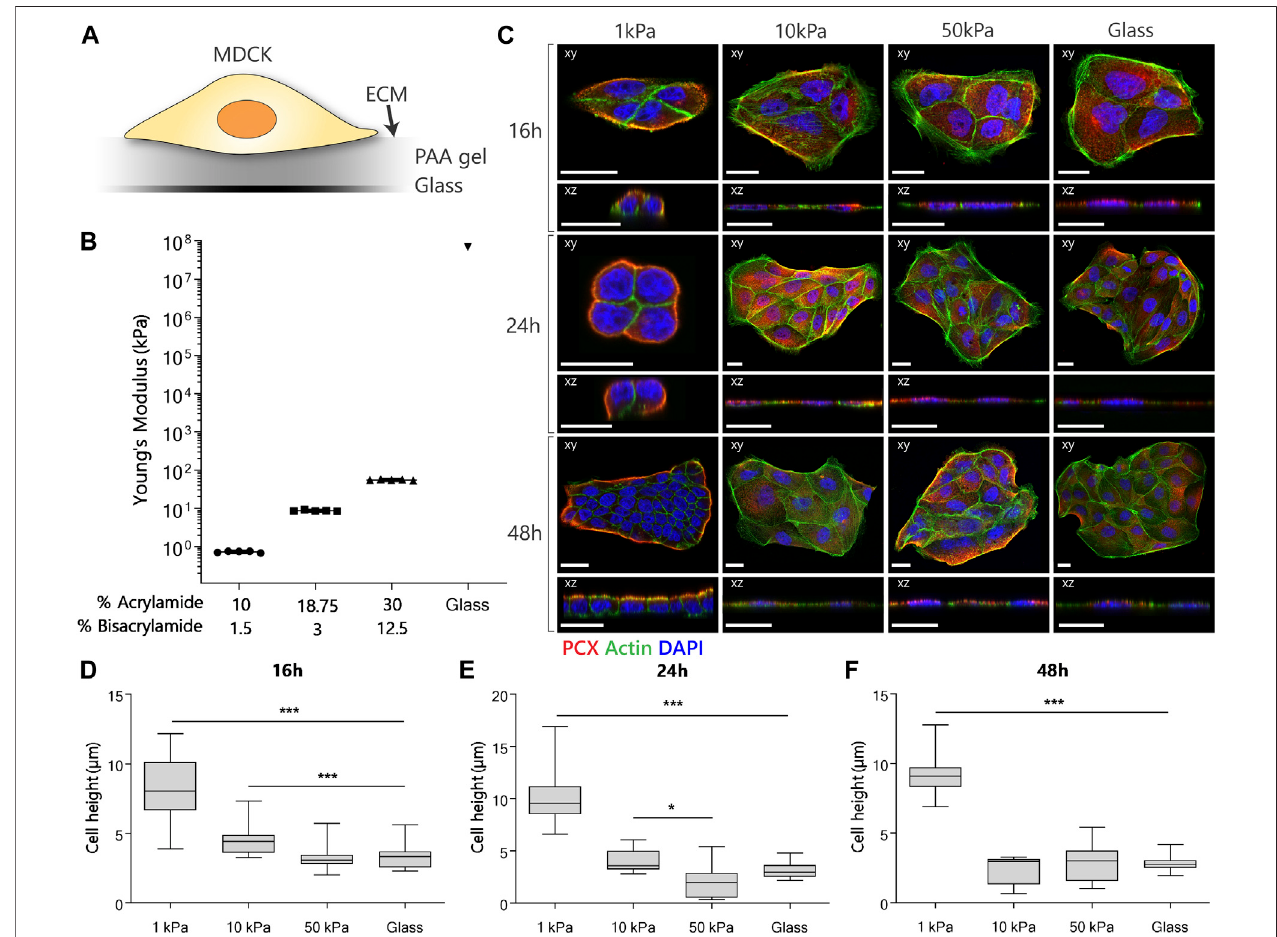
FIGURE 1 | MDCK polarization and morphology when cultured on substrates with different stiffnesses. (A) Experimental setup for the examination of the effect of different substrate stiffnesses on the establishment of apical-basal polarization. (B) The Young ’ s modulus of the substrates was veri fi ed using nanoindentation. (C) Representative fl uorescent images of MDCKs cultured on PAA substrates with an elastic modulus of 1, 10 and 50 kPa or on glass controls. The cells were stained for podocalyxin (red), actin (green) and nuclei (blue). Confocal sections are shown in both xy (top) and xz (bottom) direction. Scale bars are 20 µm. (D/E/F) Cell height quanti fi cation of MDCKs at the 16-hour (D) , 24-hour (E) and 48-hour (F) time point ( n = 3 per group) using a dedicated Matlab script. ( p -values are calculated using a Kruskal-Wallis test with a Dunn ’ s multiple comparison test, * p < 0.05, ** p < 0.01, *** p < 0.001).